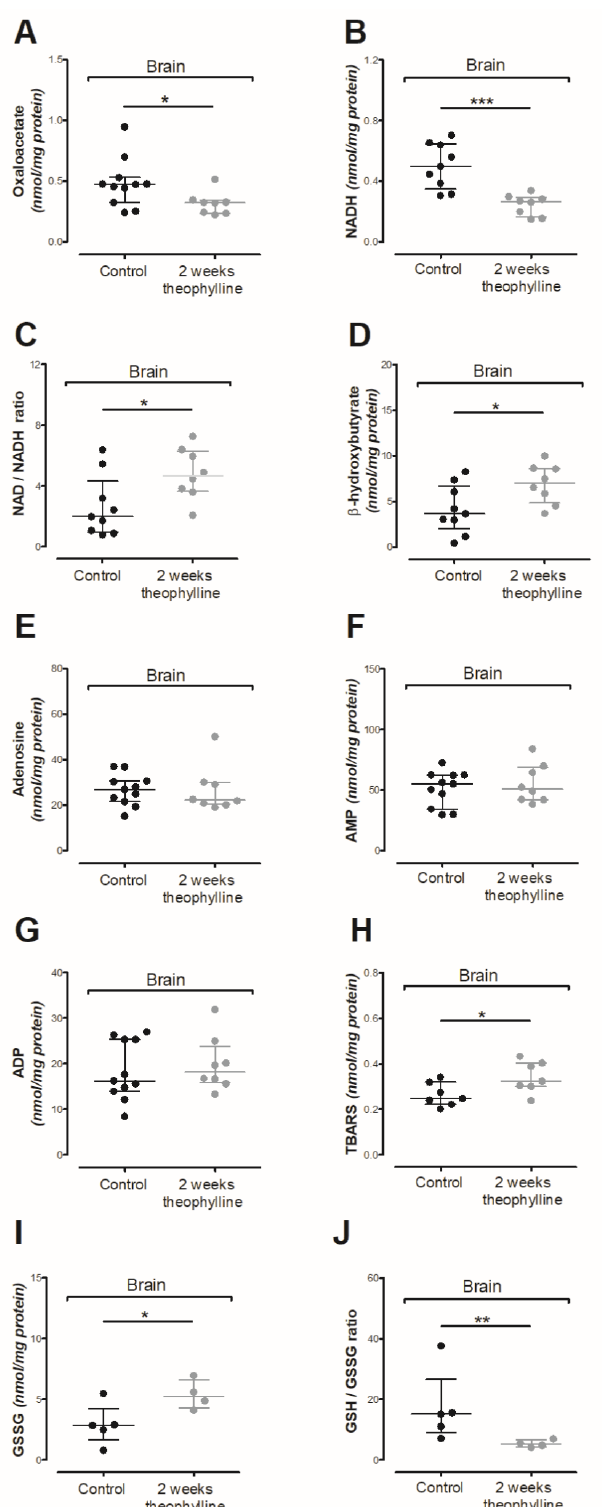
Figure 5. Impact of theophylline treatment on Wistar rat brain: ( A ) oxaloacetate level; ( B ) re- duced nicotinamide adenine dinucleotide level (NADH) level; ( C ) NADH/NAD ratio; ( D ) β - hydroxybutyrate level; ( E ) adenosine level; ( F ) AMP level; ( G ) ADP level; ( H ) TBARS level; ( I ) oxi- dized glutathione (GSSG) level; ( J ) GSSG/GSH ratio. Data are medians with interquartile ranges from 3–11 observations per group. Significantly different from the control: * ( p -value < 0.05), ** ( p -value < 0.01), *** ( p -value <